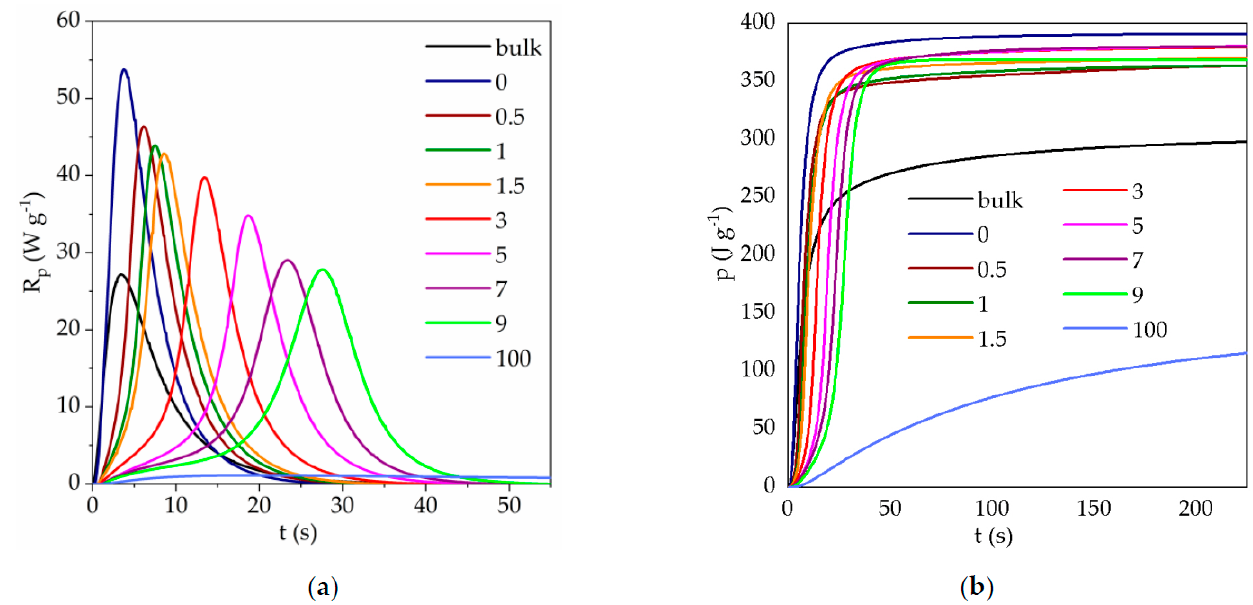
Figure 4. Photo-DSC kinetic curves ( a ) R p = f ( t ), and ( b ) p = f ( t ) for 30 wt.% (TATT + PETMP + 8M-POSS) + 70 wt.% (EMImNTf 2 + PC) system. Numbers indicate the 8M-POSS content in the matrix compositions expressed in wt.%, bulk— polymerization of TATT + PETMP composition without solvent.